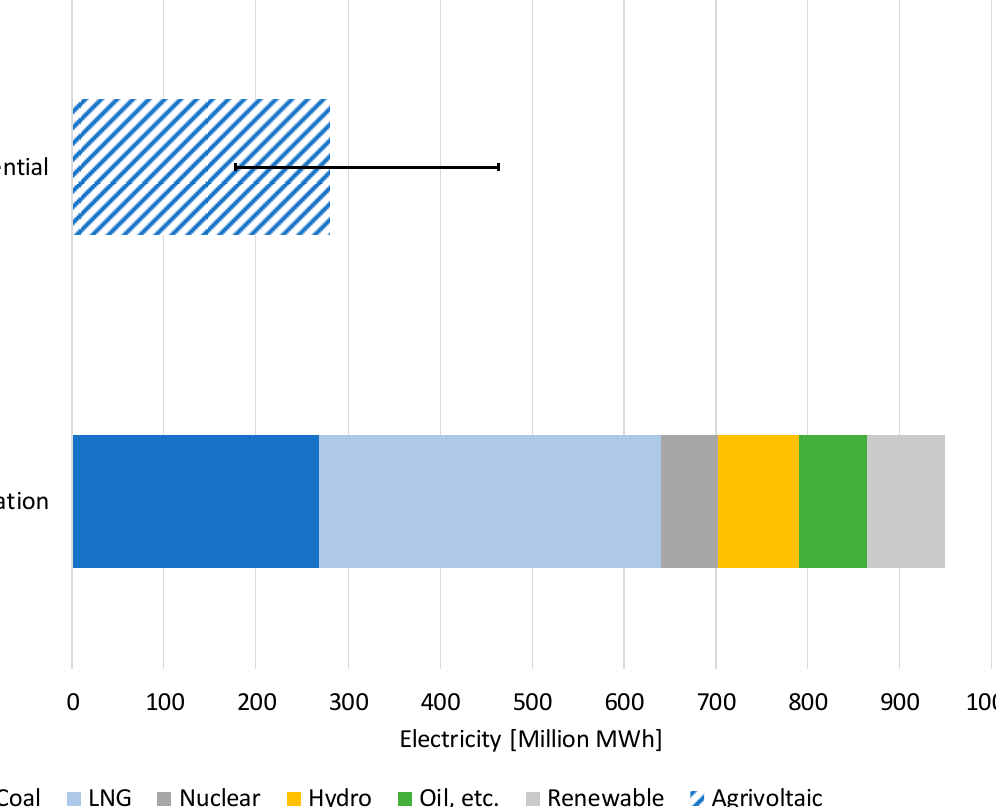
Figure 7. Potential energy output of agrivoltaic systems above rice paddies in Japan.